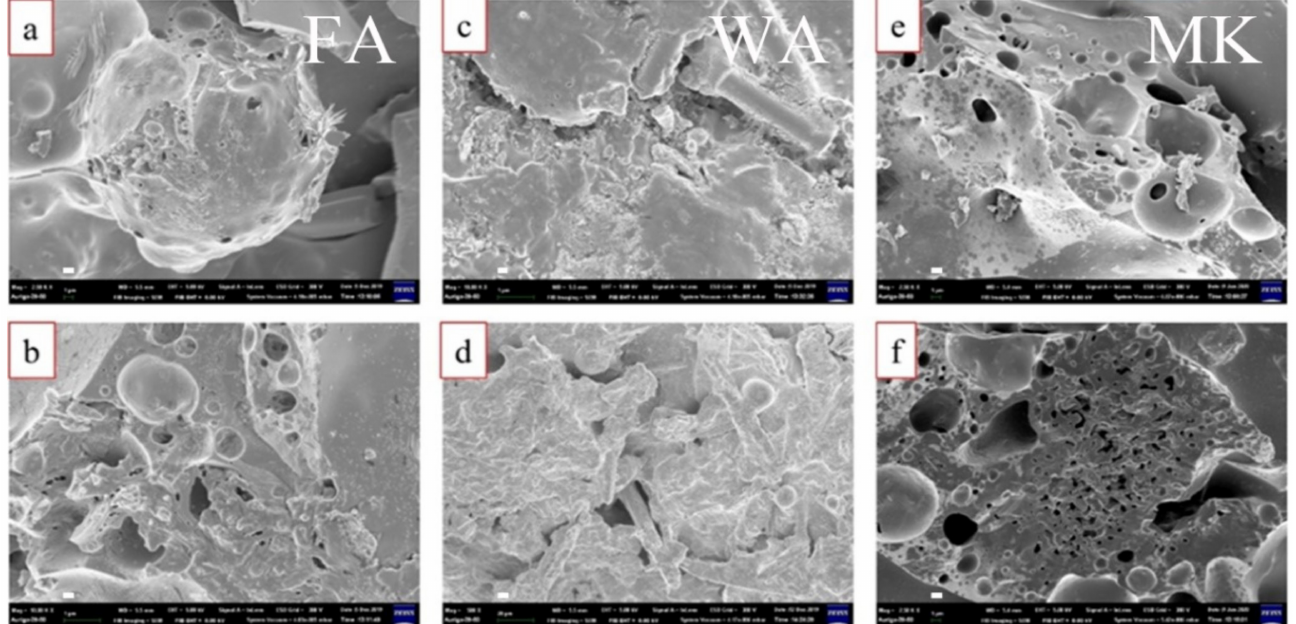
Figure 1. SEM images of sodium silicate-based intumescent materials with 9:1 of sodium silicate matrix to ( a ) fly ash, ( c ) wollastonite and ( e ) metakaolin after flame testing, respectively. The corresponding magnified morphologies ( b ), ( d ) and ( f ), respectively. (scale bar = 1 µ